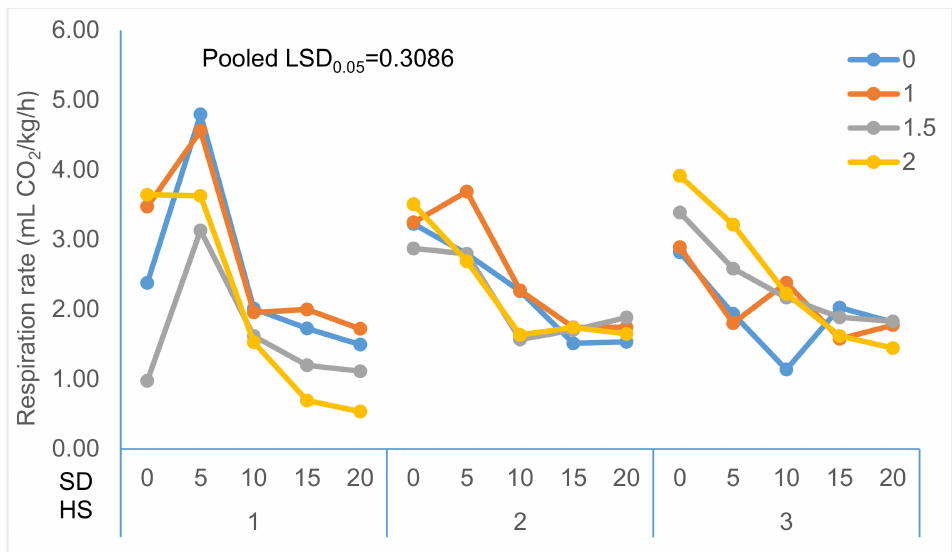
Figure 2. The interaction effects of CaCl 2 (0, 1%, 1.5%, and 2%, w / v ), harvesting stages (HS: 1 = green mature, 2 = breaker and 3 = half ripe) and storage durations (SD: 0, 5, 10, 15 and 20 days) on the rate of respiration of tomato fruit stored at ambient temperature (28 ± 2 ◦ C and 75 ± 5% RH). Pooled LSD 0.05 =